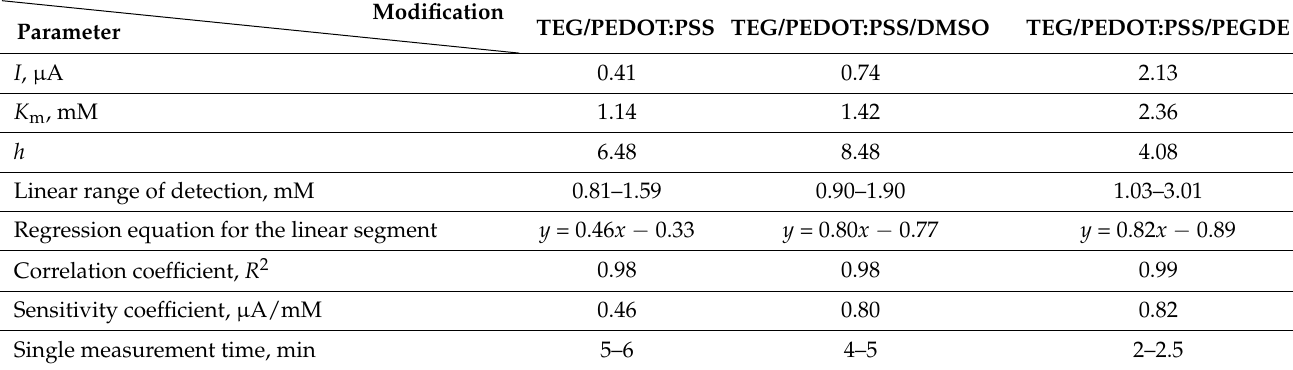
Table 1. Analytical characteristics of PEDOT:PSS biosensors for glucose.